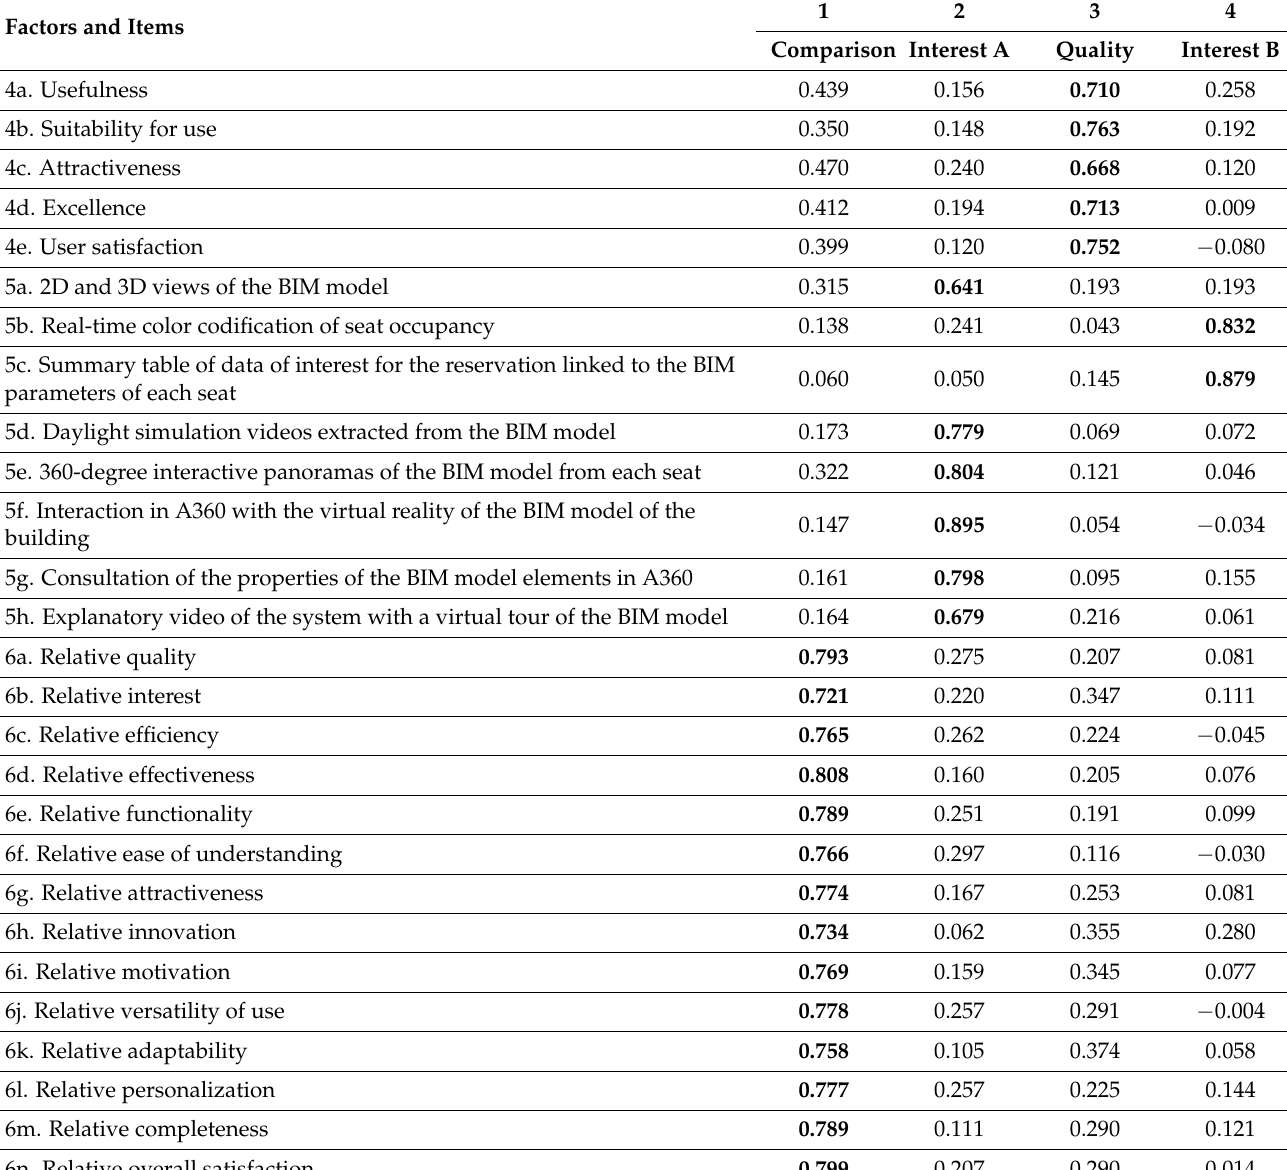
Table 10. Matrix of rotated